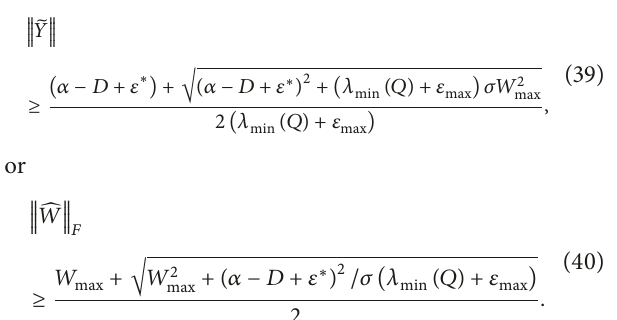
Table 2: The simulation